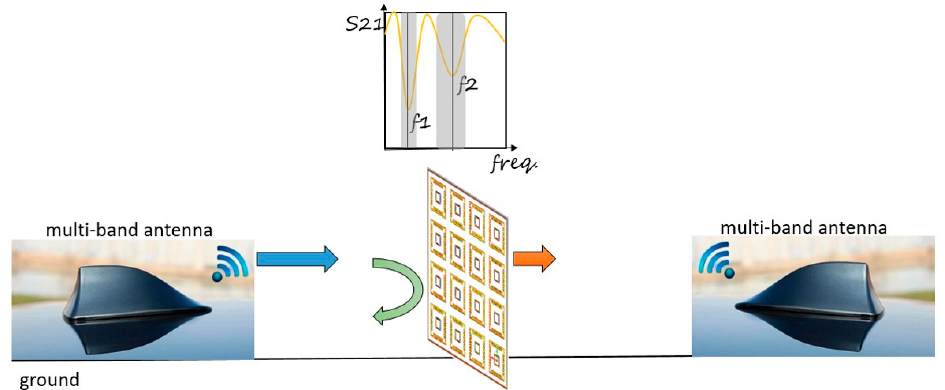
Figure 1. Operating principle of the Frequency-Selective Surface.